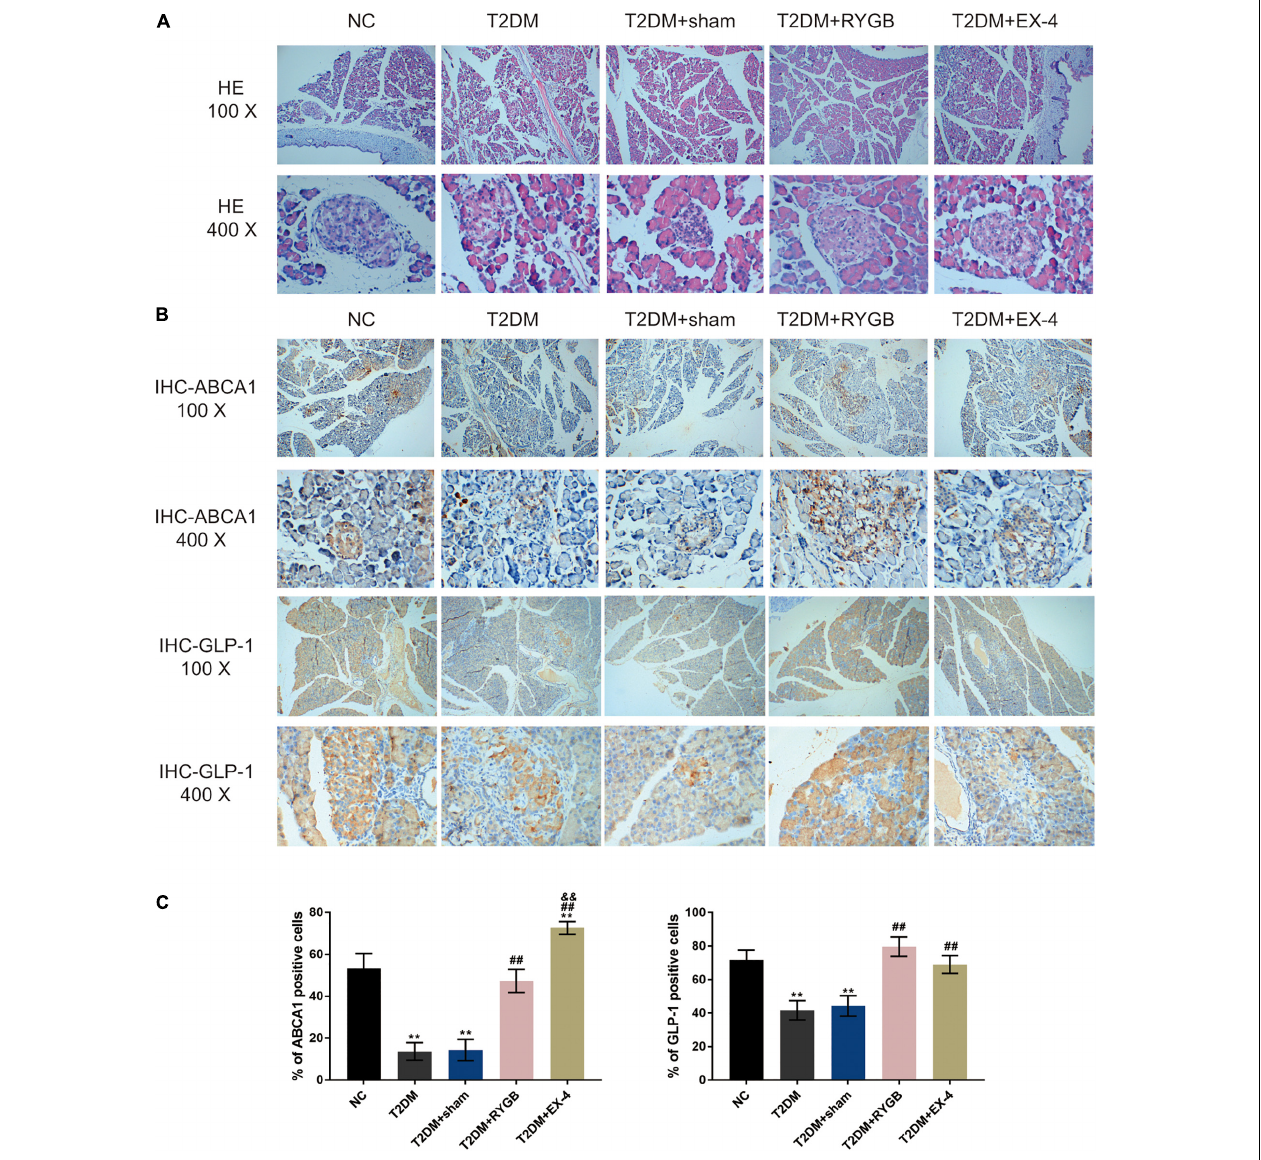
FIGURE 7 | The pancreatic islet morphology and ABCA1 and GLP-1 protein levels. Sprague-Dawley (SD) rats were randomly assigned into five groups: non-treatment control group ( n = 6), streptozotocin (STZ)-induced T2DM group ( n = 6), T2DM plus sham surgery group ( n = 7), T2DM plus RYGB surgery group ( n = 9), and T2DM plus EX-4 treatment group ( n = 8). (A) The histopathology of rats’ pancreatic tissues was examined by H&E staining. n = 6. (B,C) The protein contents and distribution of ABCA1 and PARP-1 were examined by IHC staining in rats’ pancreatic tissues. n = 6, * P < 0.05, ** P < 0.01 compared with NC group, ## P < 0.01 compared with T2DM + sham group, && P < 0.01 compared with T2DM + RYGB